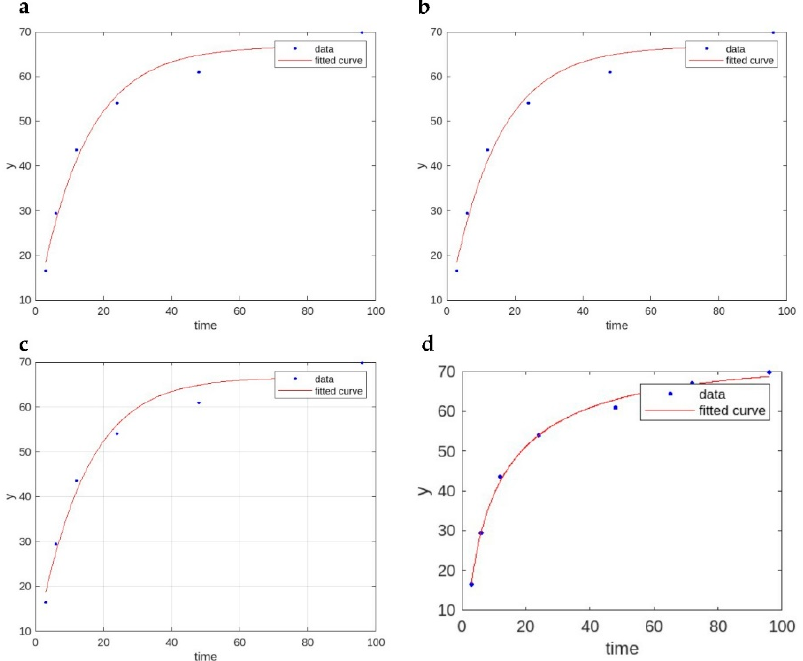
Figure 3. Ruminal fermentation curve for alfalfa forages. ( a ) Model I, ( b ) Model II, ( c ) Model III, and